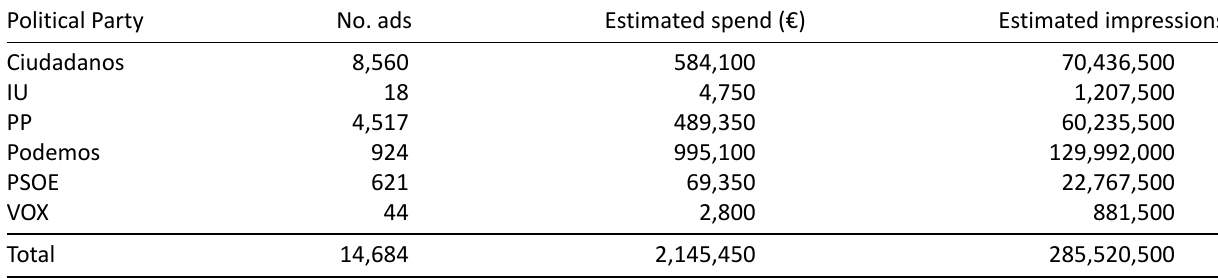
Table 1. Information on the ads making up the corpus. Political Party